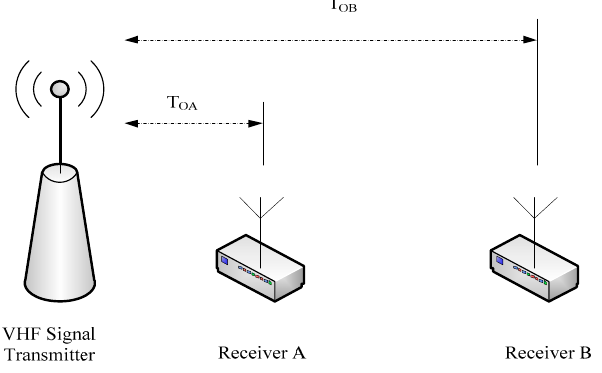
Figure 1. The basic structure of the additional secondary phase factor correction system.